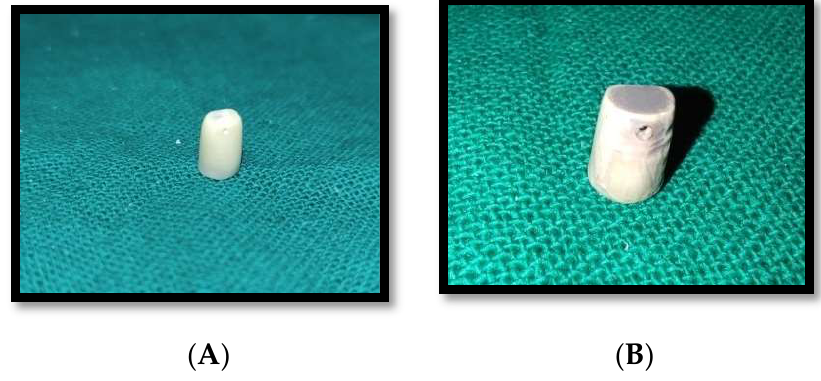
Figure 2. ( A ) PEEK coping, ( B ) Zirconia coping.